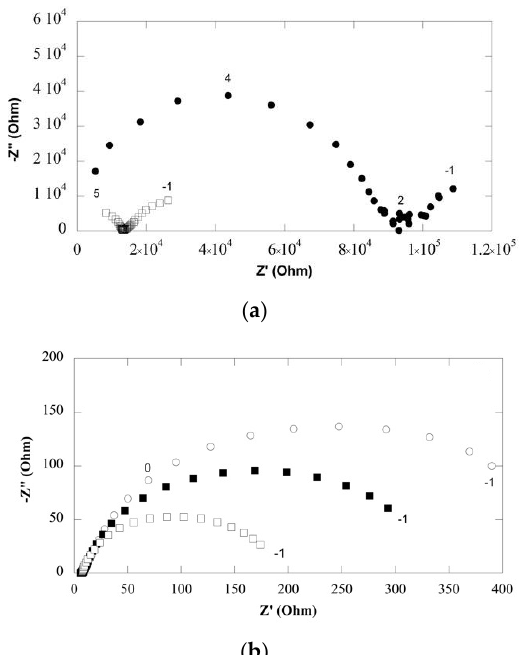
Figure 3. Impedance spectra of BZY-LK30 composites measured under air at ( a ) 350 °C ( ) and 400 °C ( ) and ( b ) at 500 °C under different amplitudes: 10mV ( ), 100 mV ( ), and 200 mV ( ). The numbers correspond to the frequency logarithm.